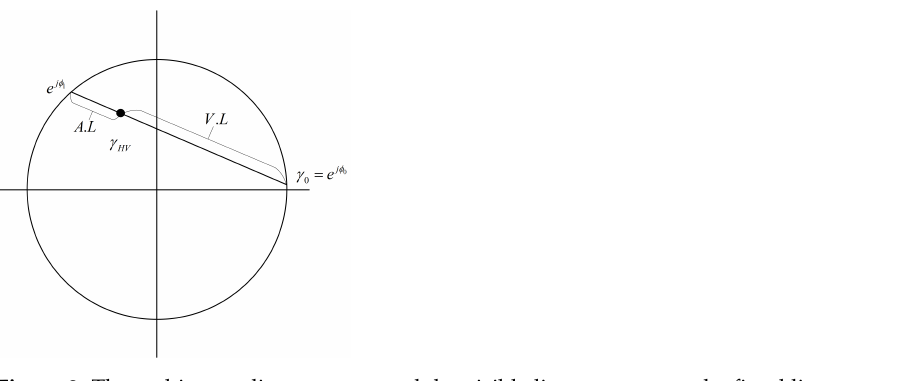
Figure 2. The ambiguous line segment and the visible line segment on the fitted